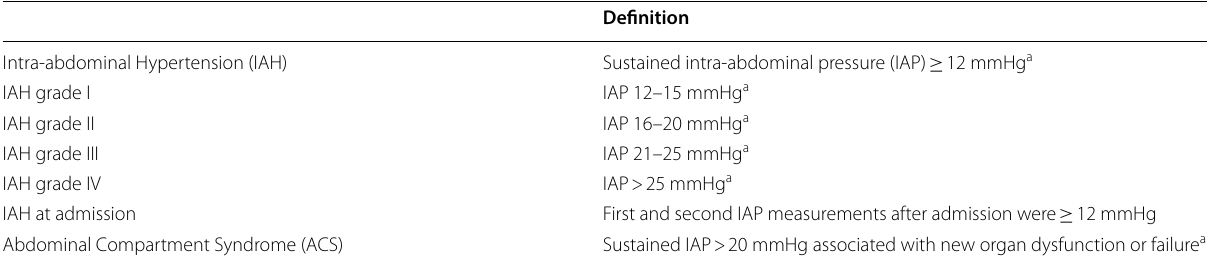
Table 1 Definitions of IAH, IAH grades and ACS